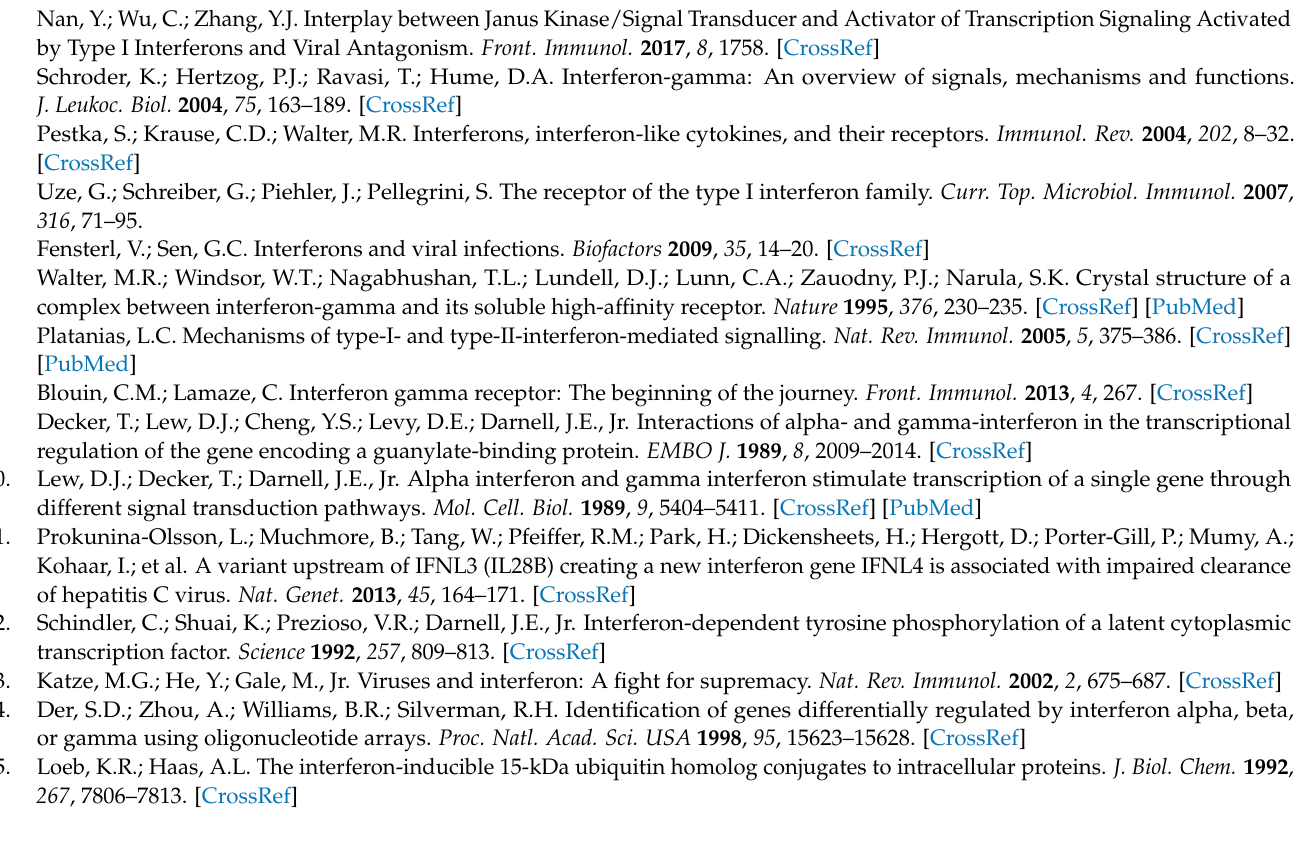
trometry analysis. Table S1, identified peptides sequence putative modification sites and protein description: Table S2, ISG15-conjugated proteins under each GO category; Table S3, COG func- tional classification of ISG15-conjugated proteins; Table S4, GO-enrichment of involving pathways of ISG15-conjugated